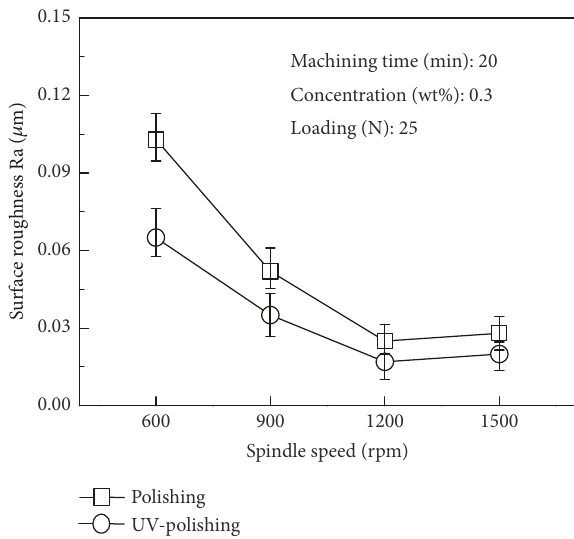
Figure 6: Impacts of concentration on surface roughness.